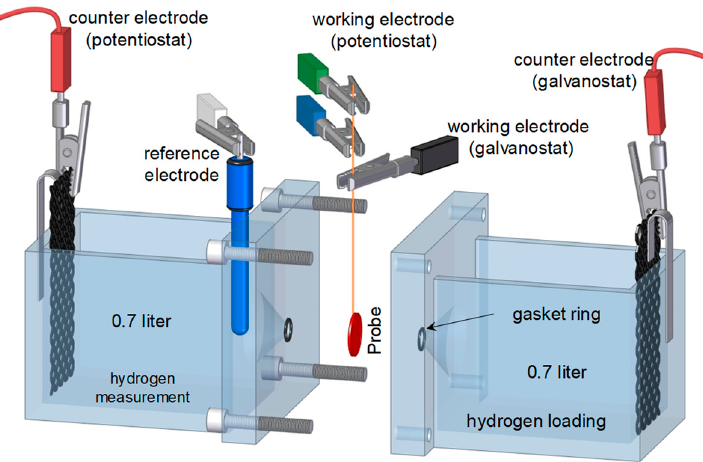
Figure 5. Structure of the double cell for permeation measurements.